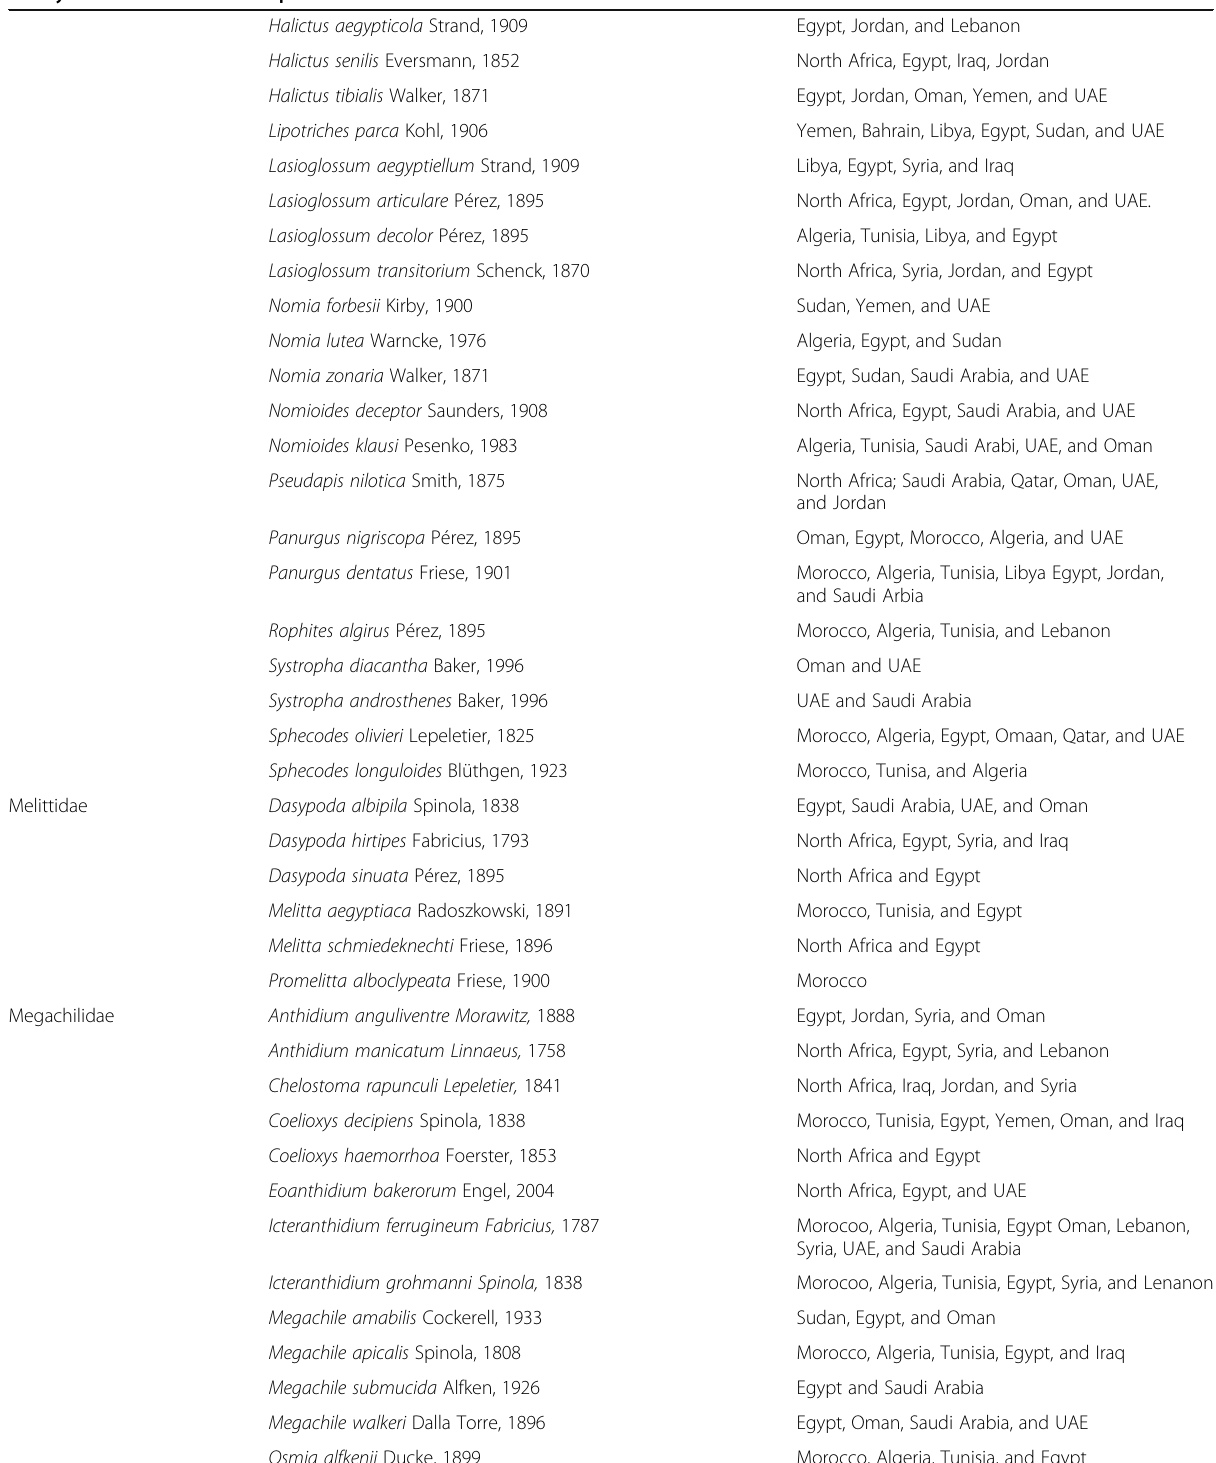
Table 1 List of some common species in North Africa and Middle East (Louadi et al., 2008; Dathe et al., 2009; Grace, 2010; Bendifallah et al., 2010a; Bendifallah et al., 2012; Kuhlmann et al., 2012; Bendifallah et al., 2013; Shebl et al., 2013; Shebl & Farag, 2015; Bendifallah & Ortiz-Sánchez, 2018; Ascher & Pickering, 2020) (Continued)